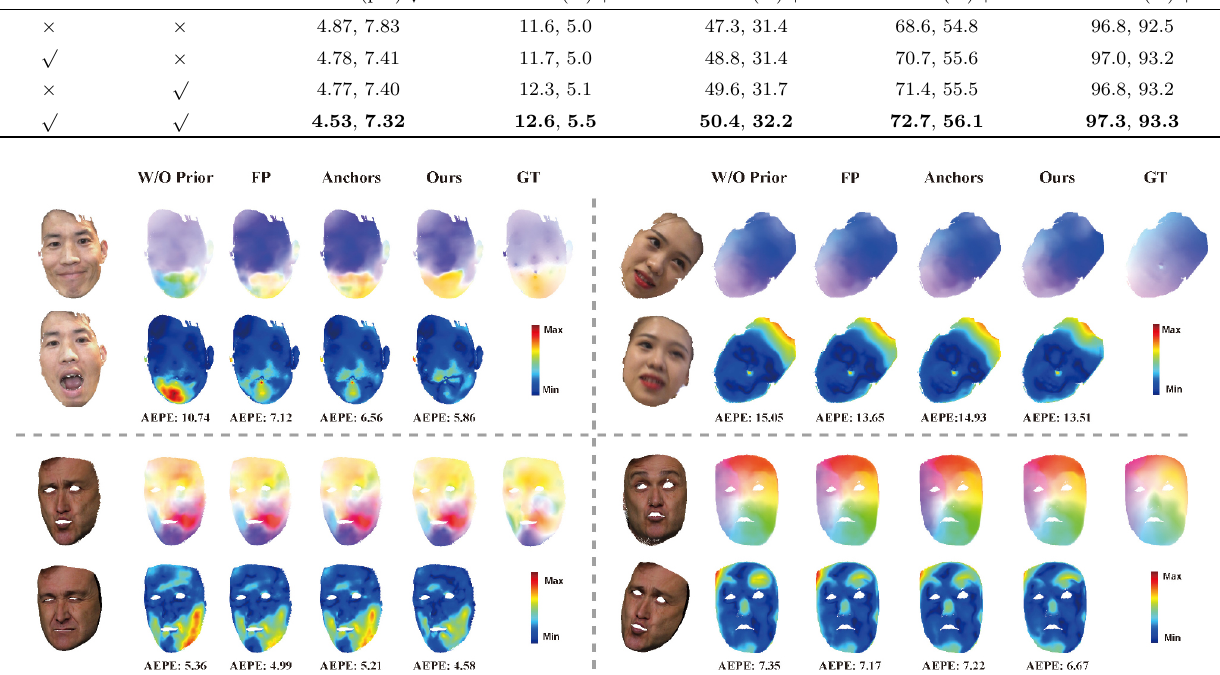
Fig. 4 Top to bottom: two qualitative results of our ablation study on the unoccluded regions from the FaceFlowData and Synthetic Face datasets, respectively. For each sample, W/O Prior represents training without anchors or FP priors. FP: results utilizing facial parsing priors during the training. Anchors: results only using anchor information during non-rigid alignment. Ours: training with all